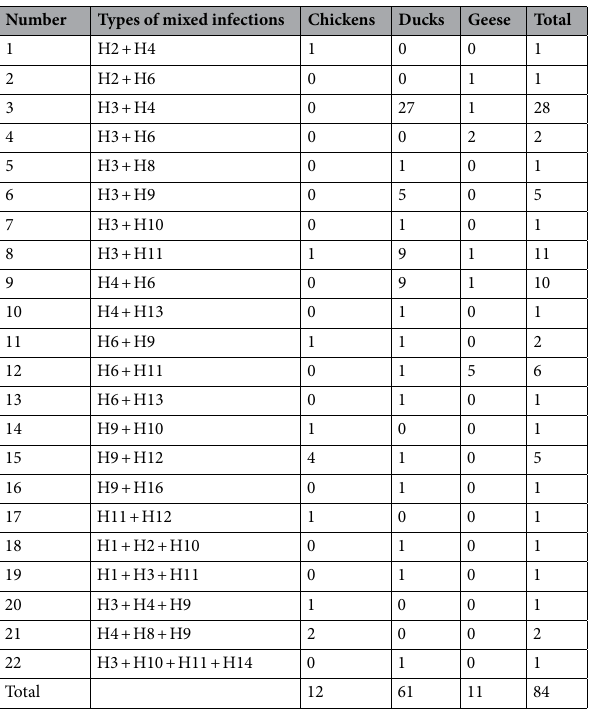
Table 2. Mixed infections involving different HA subtypes in chickens, ducks and